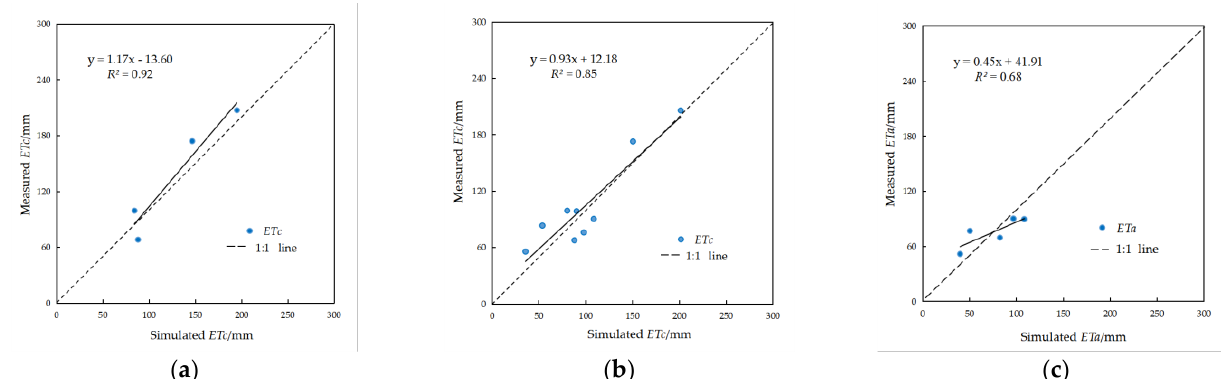
Figure 4. Calibration for ( a ) Harbin (2014) and verification of the measured and simulated ET c for ( b ) Harbin (2015) and Zhaozhou (2014); ( c ) ET a for Zhaozhou (2017) under the irrigation and rainfed scenarios. ET c : crop water requirements, ET a : actual crop evapotranspiration, same as below. Table 3. The goodness-of-fit indexes from the growing-season model simulation: yields in 2014, 2015, and 2017.